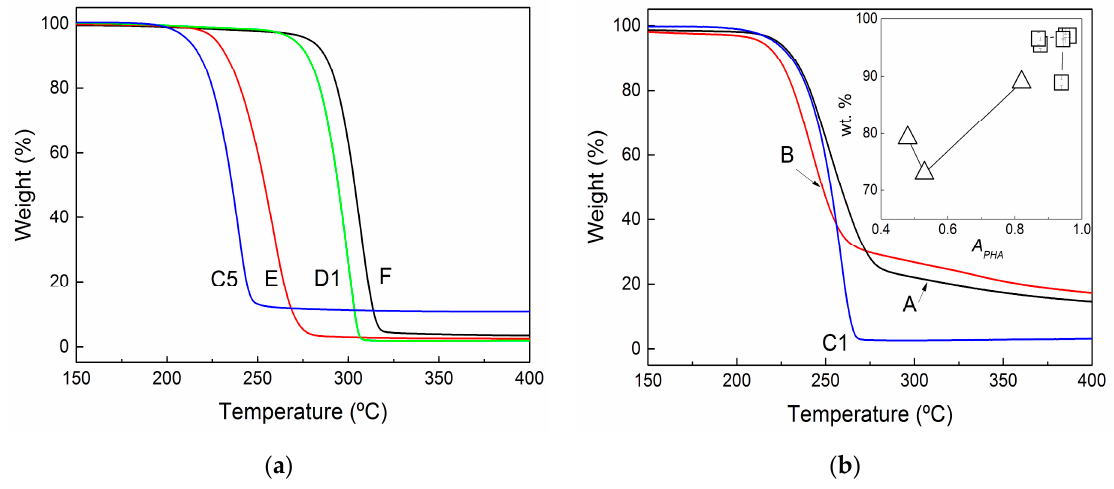
Figure 5. TGA curves of recovered films extracted with chloroform ( a ) and of pellets recovered after biomass digestion with NaOH ( b ). The inset in ( b ) relates the PHA purity inferred from both FTIR (squares) and DRIFT (triangles) analyses to the purity measured in weight percent (wt%) by using TGA.